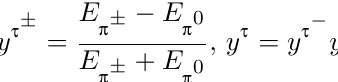
JHEP06(2022)012